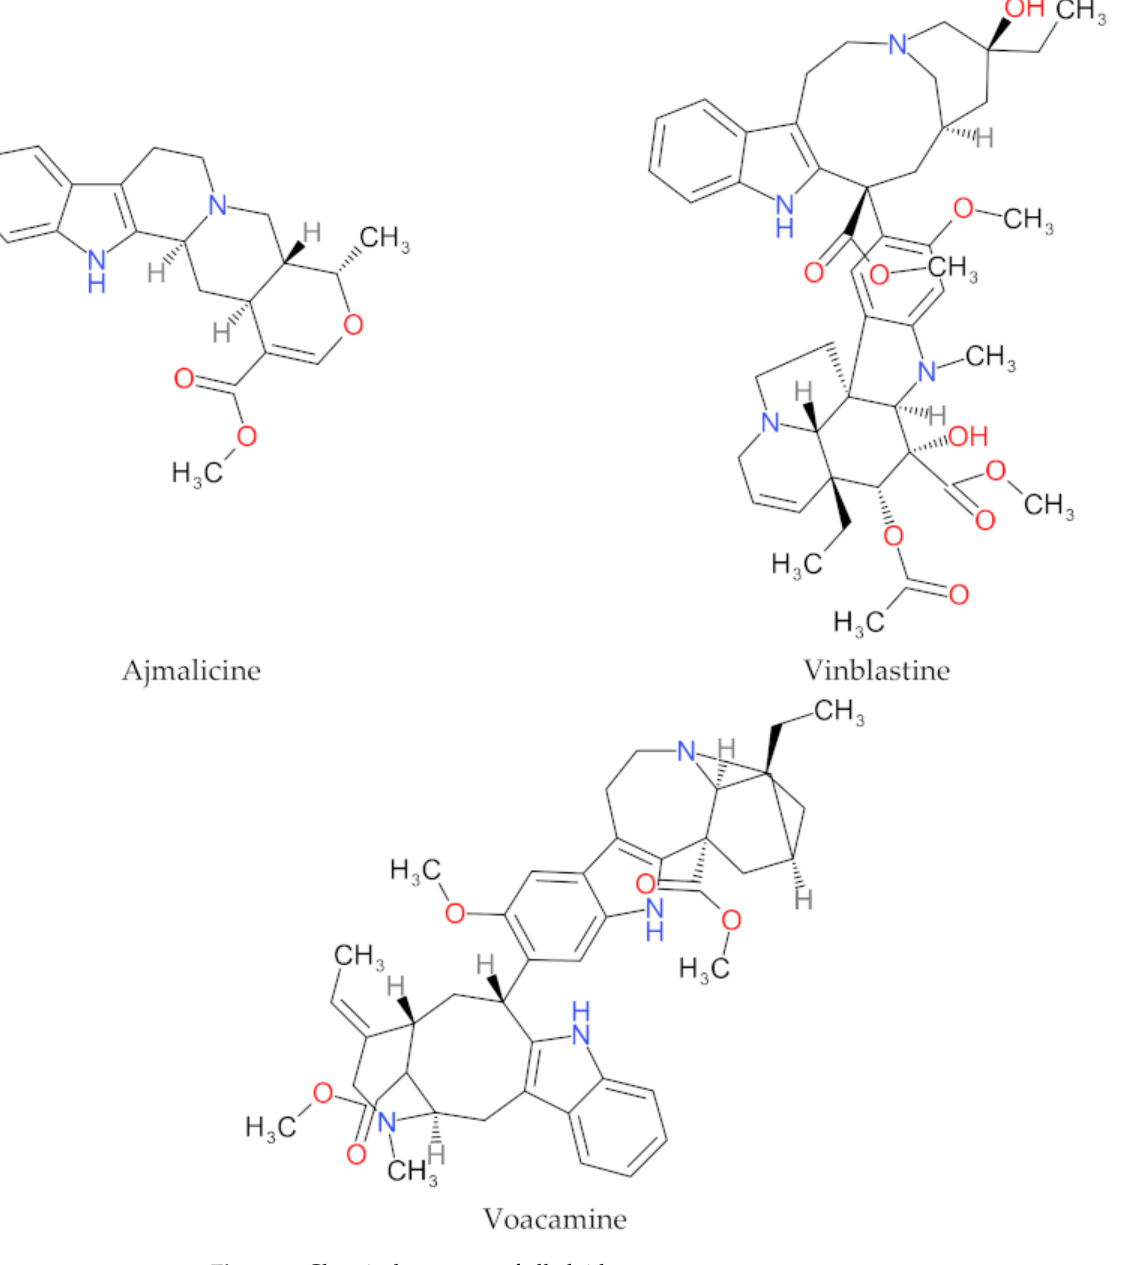
Figure 1. Chemical structure of